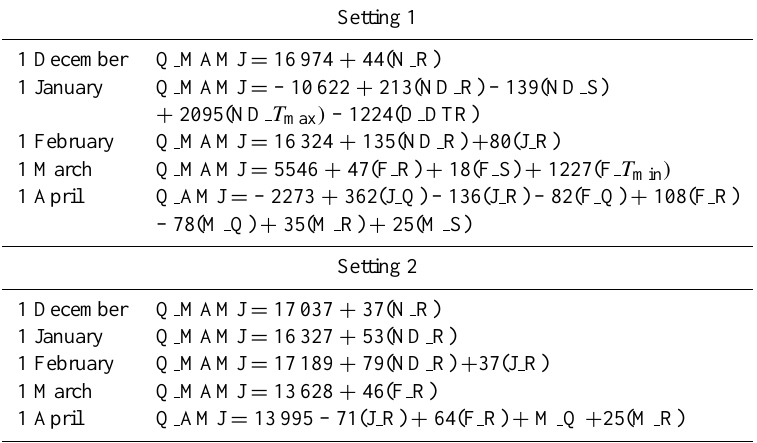
Note: flow ( Q ) is in cubic feet per sec (cfs), rainfall ( R ) and snow ( S ) are in millimeters (mm) and temperature ( T ) is in degrees centigrade ( ◦